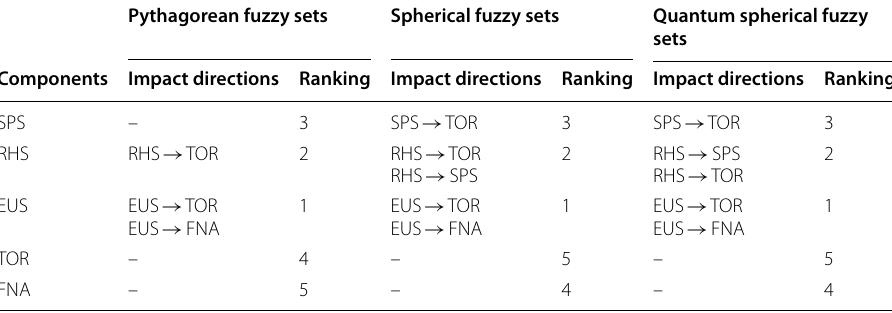
Table 19 Comparative ranking results and impact relations of the